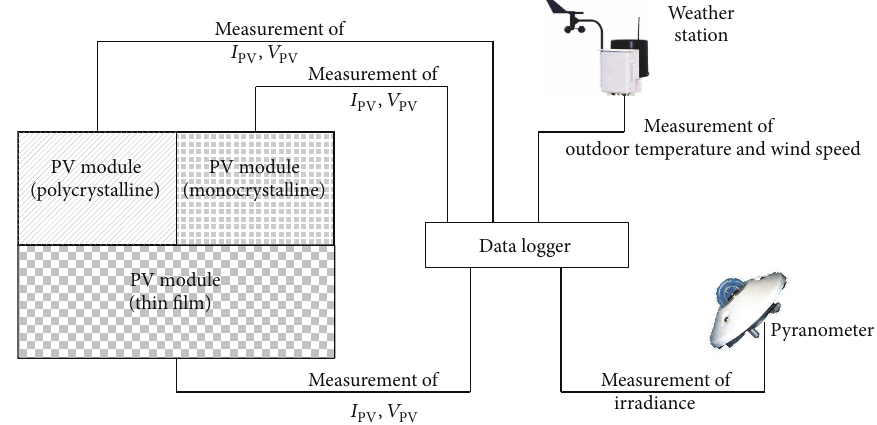
Figure 6: Schematic representation of complete measurement setup.